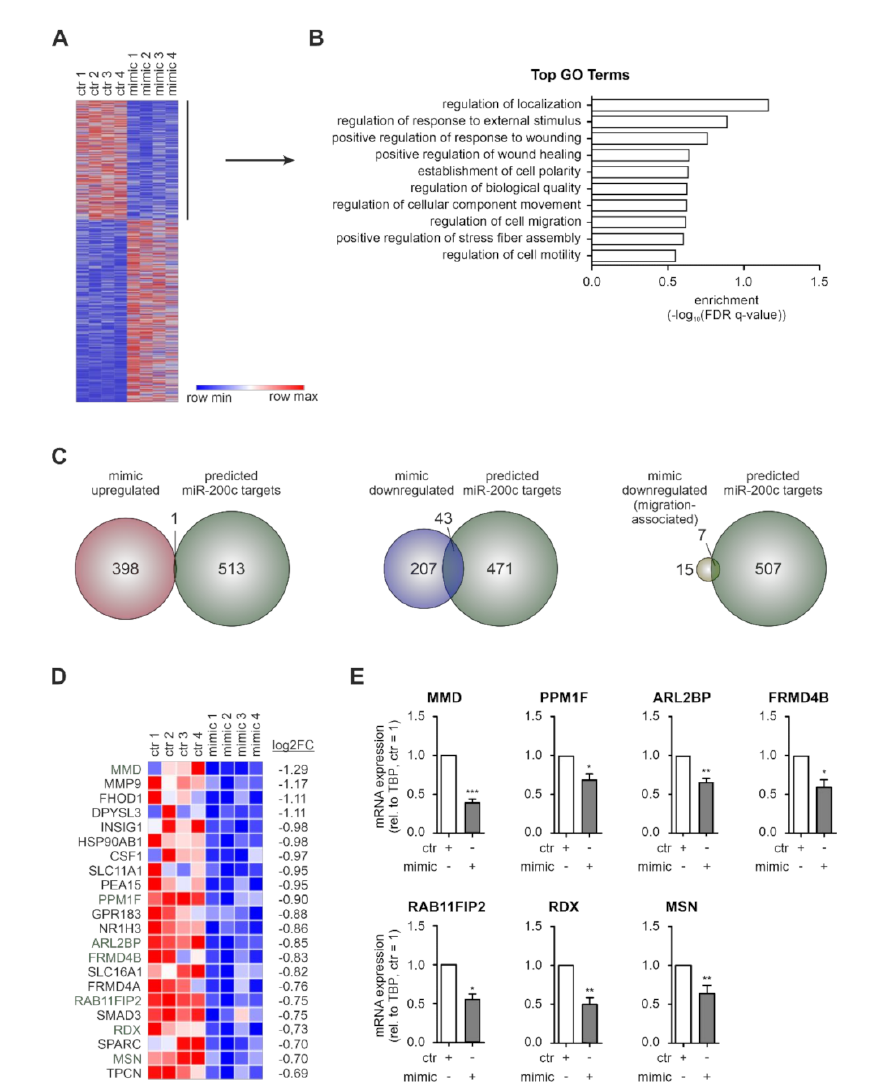
Figure 3. RNA-sequencing of miR-200c overexpressing M Φ identifies downregulation of migration- associated mRNAs. Primary human macrophages (M Φ ) were transfected with miR-200c mimic (mimic) or mimic control (ctr) 72 h before mRNA was isolated for mRNA sequencing. ( A ) Heatmap of 649 differentially expressed genes in miR-200c-transfected M Φ (|log2FC| ≥ 0.66). ( B ) GO term analysis was performed with the 250 downregulated targets (log2FC ≤ − 0.66) using GOrilla [39] and the top 10 processes (according to their p -value) are shown. ( C ) Venn diagrams intersecting predicted miR-200c targets (green) with targets upregulated (red; left panel ) or downregulated (blue; middle panel ) in mimic-transfected M Φ , and with targets downregulated in mimic-transfected M Φ associated with migration-related GO terms (yellow; right panel ). ( D ) Heatmap depicting targets downregulated in mimic-transfected M Φ associated with migration-related GO terms (green: pre- dicted miR-200c targets). ( E ) Expression of mimic downregulated, migration-associated, predicted miR-200c targets MMD (monocyte to macrophage differentiation-associated 1), PPM1F (protein phosphatase 1F), ARL2BP (ADP-ribosylation factor-like protein 2 binding protein), FRMD4B (FERM domain-containing 4B), RAB11FIP2 (RAB11 family-interacting protein 2), RDX (radixin), and MSN (moesin) was validated in M Φ 72 h after mimic transfection by qPCR. Data were normalized to ctr M Φ and are depicted as mean ± SEM ( n ≥ 4; * p < 0.05, ** p < 0.01, *** p <